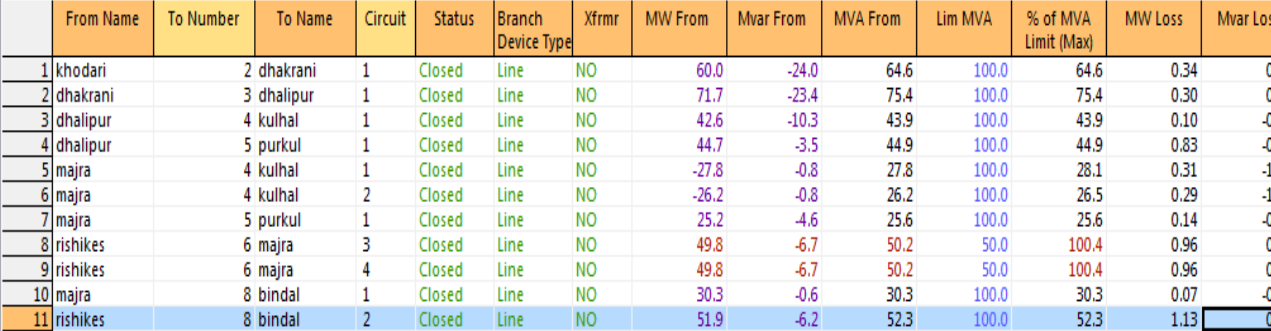
TABLE. 9 SYSTEM DATA OBTAINED FROM PWS AFTER FIRST ITERATION.